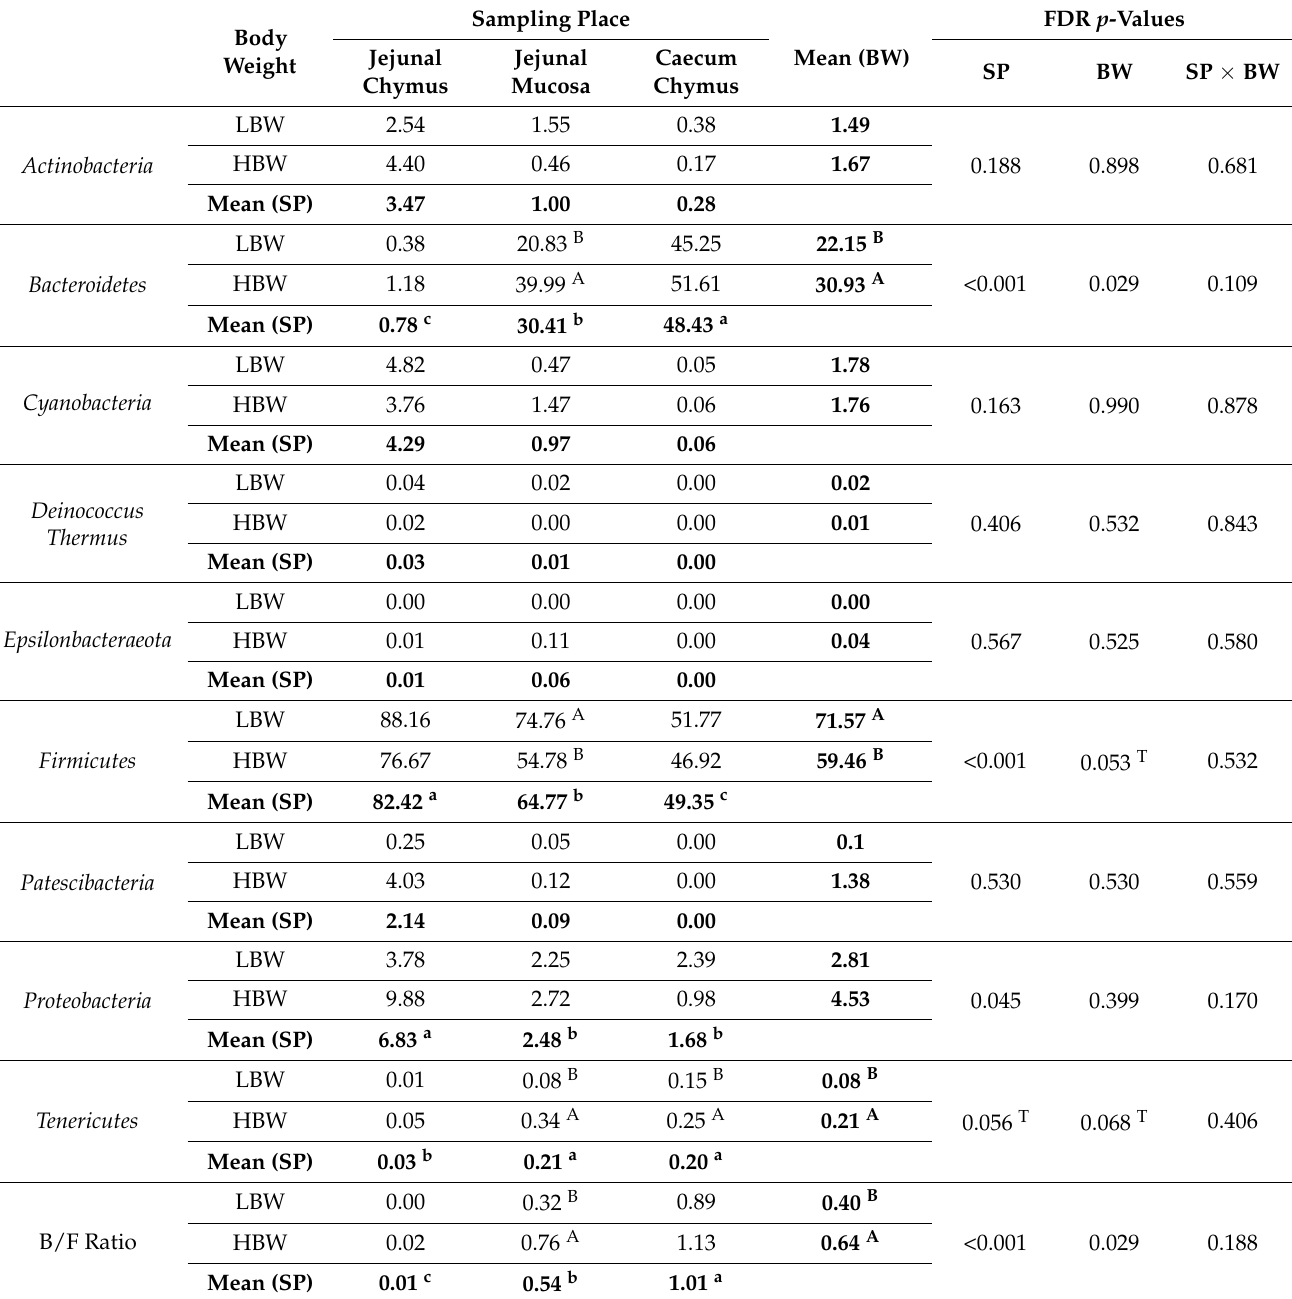
Table 2. Relative abundance of bacterial phyla in the different sampling places of broiler chickens as affected by BW